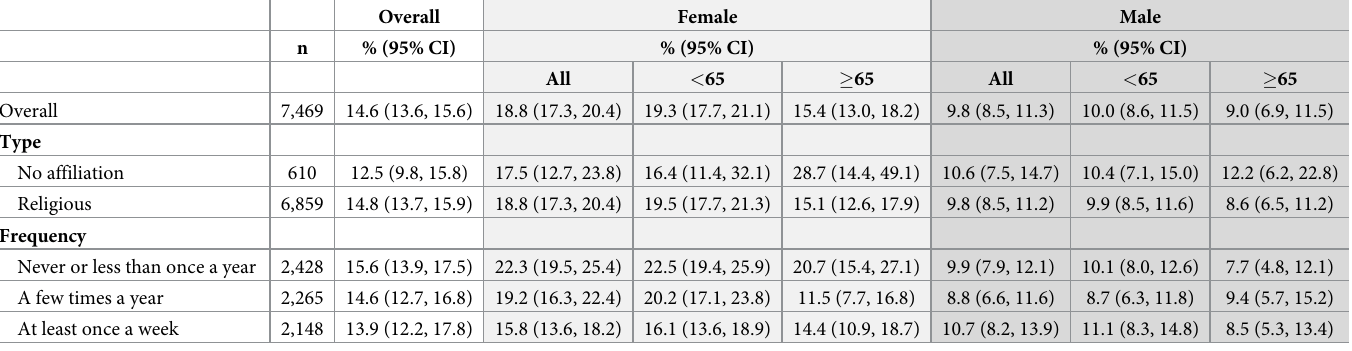
Table 2. Weighted prevalence of major depressive episode (mde) by religiosity, age and sex.